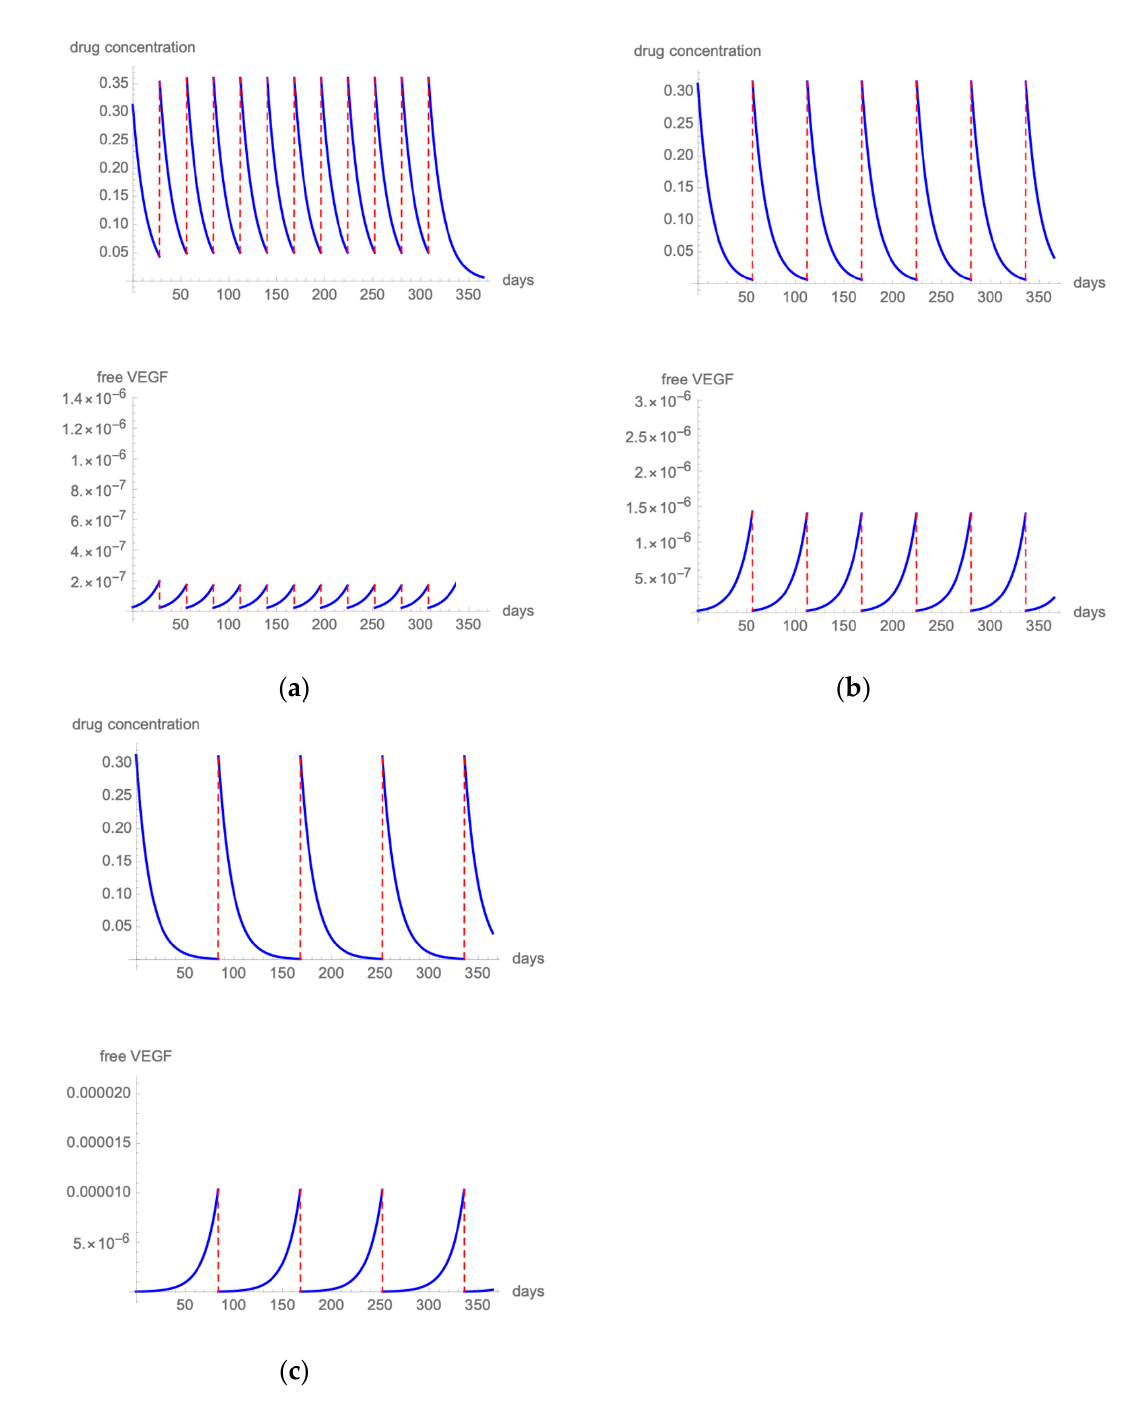
Figure 3. Figure 3 illustrates the intravitreal drug concentration and free VEGF proportion in a pa- tient treated with q4 ( a ), q8 ( b ), or q12 ( c ) 1.25 mg bevacizumab